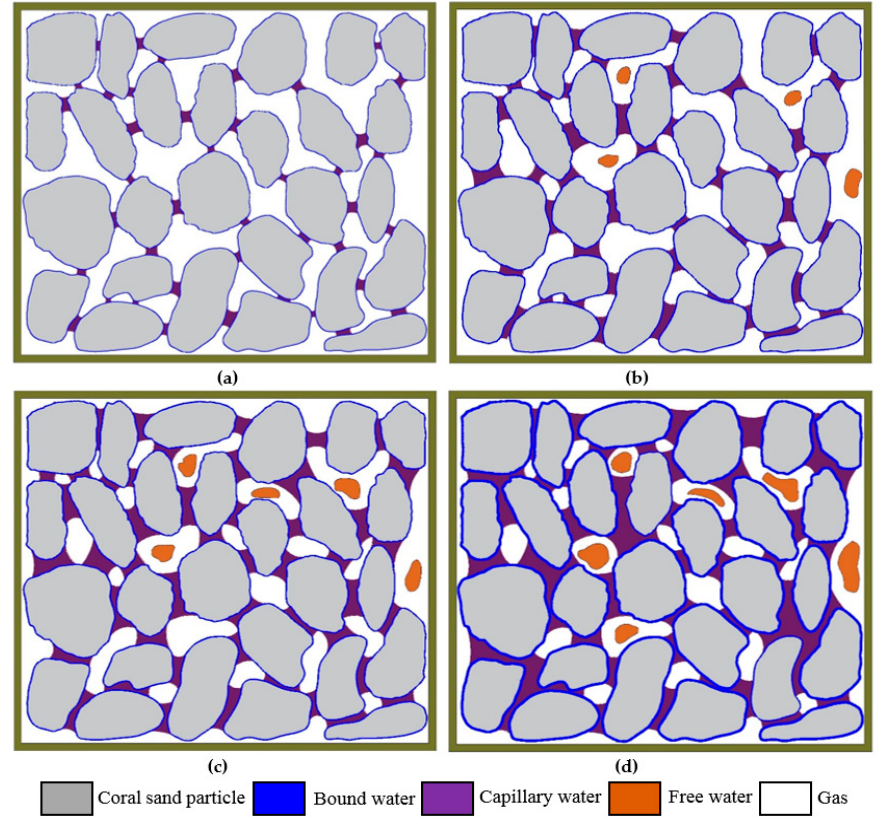
Figure 10. Schematic diagram of pore water in different occurrence forms under different